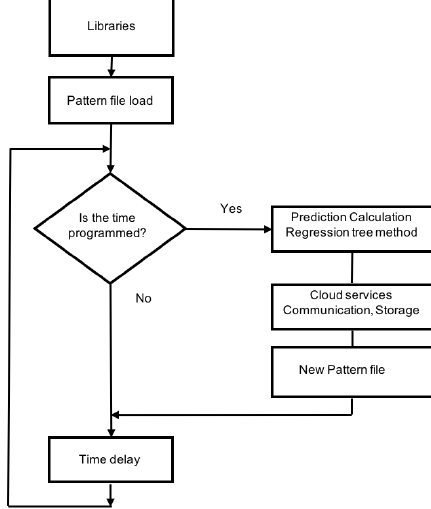
Figure 21. Power prediction algorithm using the regression tree